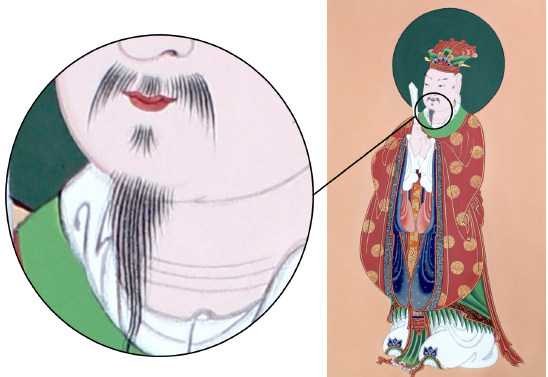
Figure 8. Detailed depiction of a Buddhist painting. The painters in traditional Korean painting require several tens of hours to create such a detailed depiction. This is why the marker tools should be as light as possible.